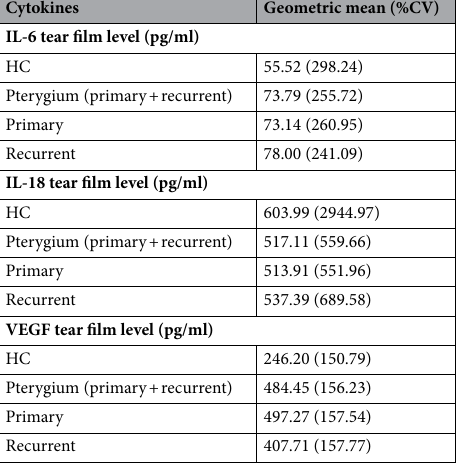
Table 2. Tear cytokine concentration in each group of participants. %CV = percent coefficient of variation; IL = interleukin; HC = healthy control; VEGF = vascular endothelial growth